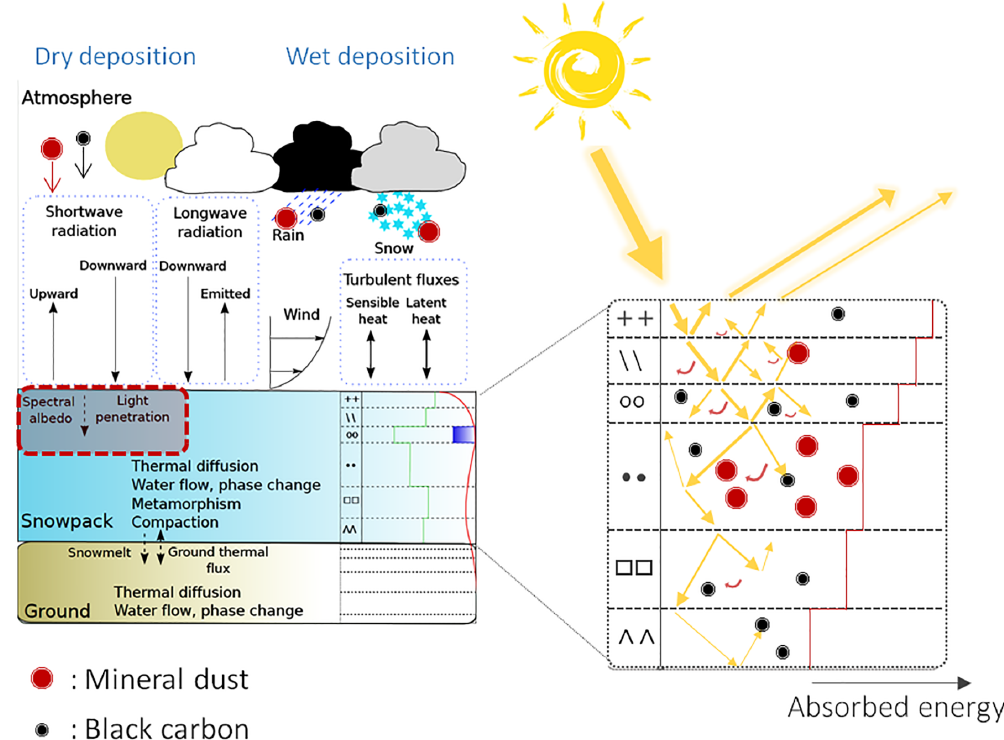
Figure 1. Description of the detailed snowpack model Crocus including an explicit representation of LAI deposition and